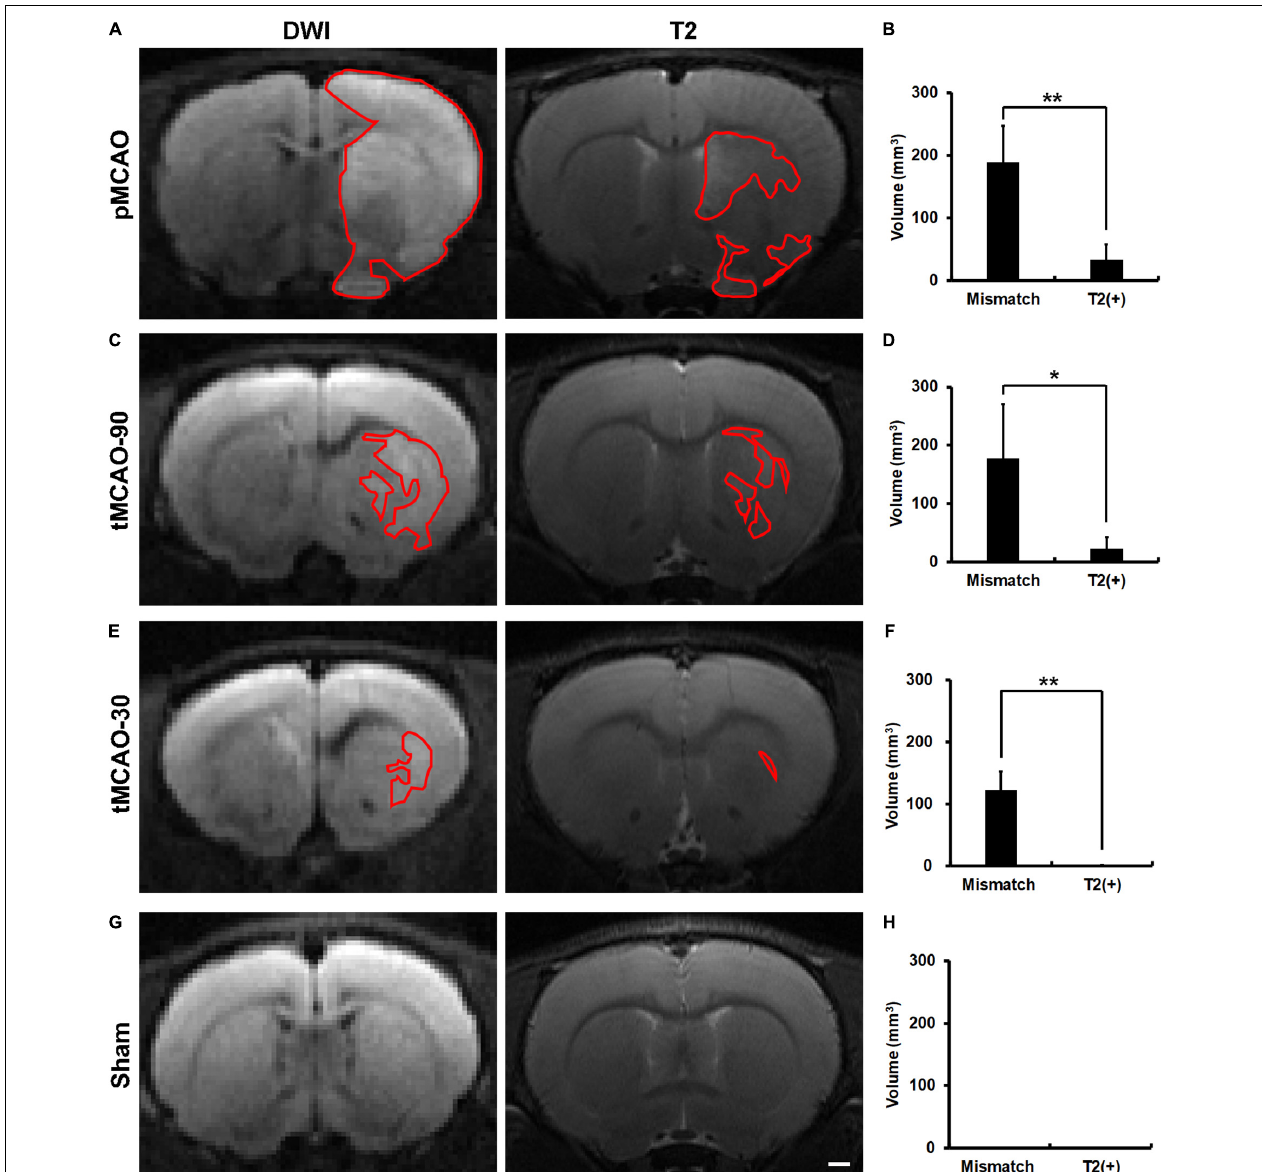
FIGURE 1 | Brain MR images of rats, within 4.5 h after permanent middle cerebral artery occlusion (pMCAO), transient middle cerebral artery occlusion (tMCAO), or sham operation. (A,C,E,G) Representative images of DWI and T2 at the corresponding sections of rat brains after pMCAO (A) , tMCAO 90 min (tMCAO-90, C ), tMCAO 30 min (tMCAO-30, E ), and sham operation (G) . The areas outlined by red lines indicates the regions with hyperintensity. The hyperintense areas on both T2 and DWI were defined as T2(+) regions, while those with hyperintensity on DWI but not on T2 were the mismatch areas. (B,D,F,H) These graphs show the comparison of the volumes of mismatch and T2(+) regions among the pMCAO ( B , n = 8), tMCAO-90 ( D , n = 5), tMCAO-30 ( F , n = 4), and sham ( H , n = 4) groups. The volumes of the mismatch areas were significantly larger than those of the T2(+) areas in the three ischemic conditions (* p < 0.05; ** p < 0.01). The T2(+) volumes in the tMCAO-30 group were significantly smaller than those in the pMCAO ( p = 0.007) and tMCAO-90 groups ( p = 0.014), while the T2(+) volumes were similar between the tMCAO-90 and pMCAO groups. (G,H) Sham-operated animals ( n = 4) did not have hyperintensity lesions on DWI and T2 weighted images. Scale bar = 10 µ